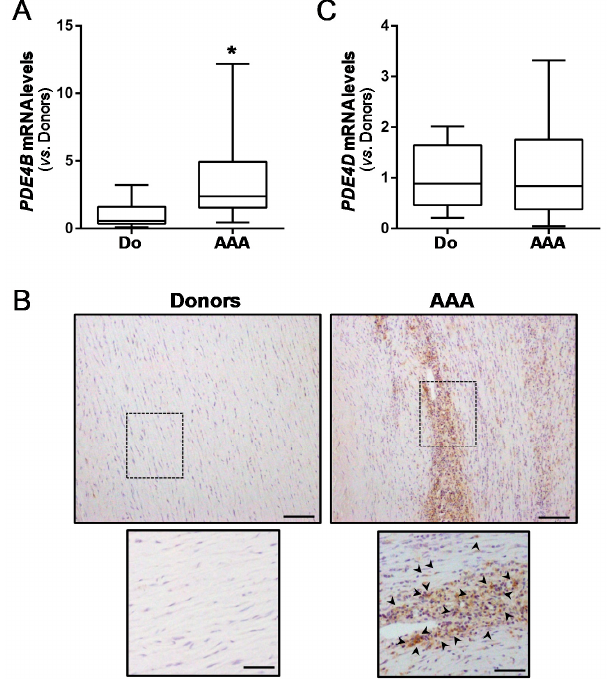
Figure 2. PDE4B expression is enhanced in human AAA. ( A ) PDE4B expression in abdominal aorta from AAA patients (AAA) and healthy donors (Do), assessed by real-time PCR. The data are presented as boxplots. The box extends from the 25th to the 75th percentile, and the median is indicated by a horizontal line. The whiskers represent the maximum and minimum values (DO, n = 14; AAA n = 61); * p < 0.001 vs. Donors. ( B ) Representative PDE4B immunostaining in healthy aorta from donors and aneurysmal tissues from AAA patients (top panels; bar: 100 µm). The boxed areas are shown at a higher magnification below, and the arrowheads indicate PDE4B-positive cells (lower panels; bar: 50 µm). ( C ) PDE4D mRNA levels in these samples.